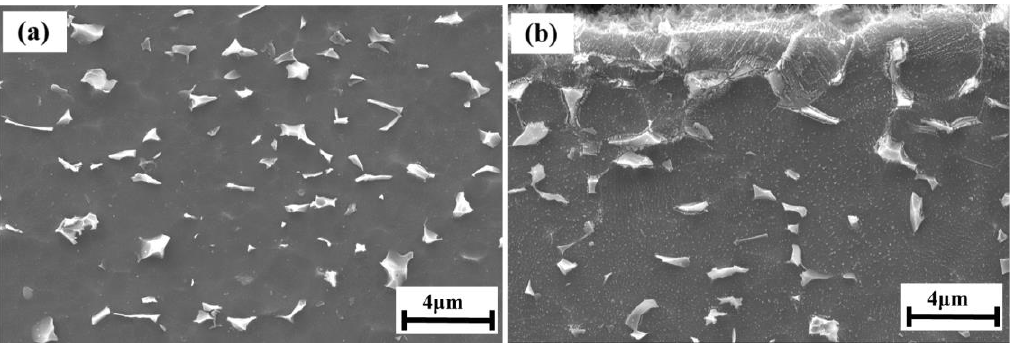
Figure 4. Cross-section morphologies of Ti6Al4V alloy before ( a ) and after ( b ) 1 h hydrogen charging in 3.5 wt.% NaCl solution.